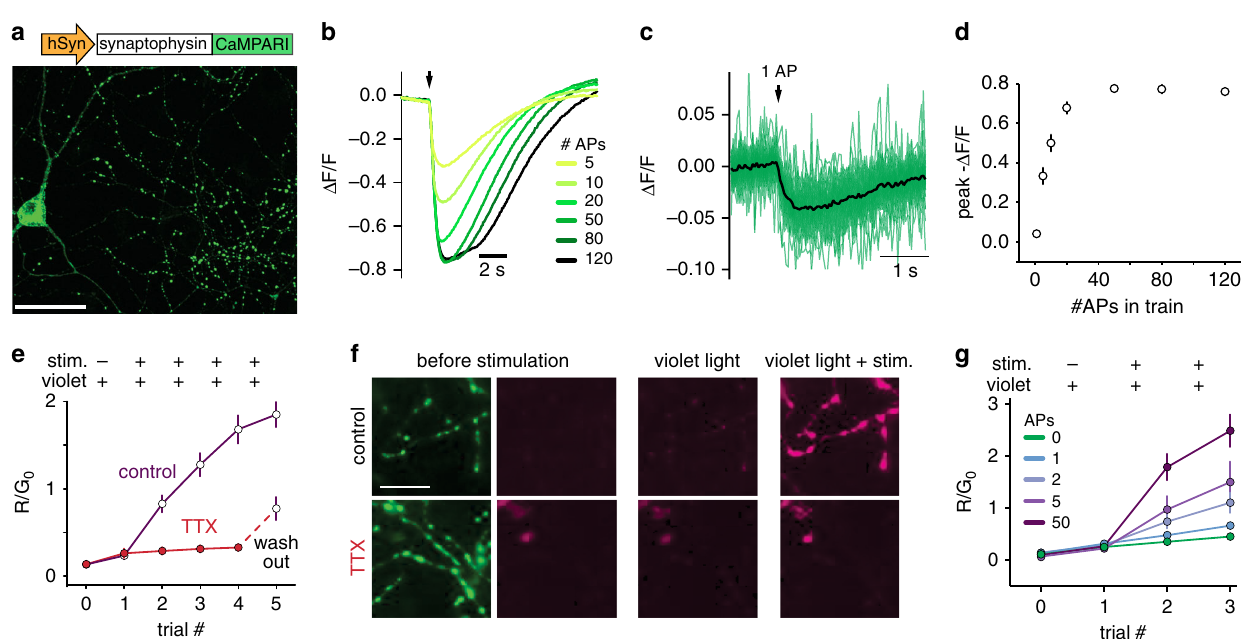
Fig. 1 Synaptophysin-fused CaMPARI marks active presynaptic terminals. a Representative image of cultured rat hippocampal neurons expressing sypCaMPARI. Note the clear punctate labeling of axonal boutons. b Average fl uorescence response of sypCaMPARI boutons (green channel emission) to varying numbers of action potentials (APs) evoked at 50 Hz ( n = 6 neurons, 317 synapses). c Trial-averaged responses to 30 single APs (green, n = 57 synapses). Black line is the average response of n = 3 neurons. d Plot of the maximum Δ F/F versus number of APs from the experiments in b and c . e Plot of initial red to green ratio of boutons expressing sypCaMPARI at baseline, after photoconverting violet light alone (20 light pulses of 1 s duration at 0.1 Hz, 405 nm, 10.8 mW cm − 2 ) and after simultaneous stimulation with trains of 50 APs at 50 Hz (trials 1 – 4). The experiment was performed in the absence or presence of 3 µ M tetrodotoxin to block action potentials (control: n = 8 neurons; TTX: n = 7 neurons). Note that after washing out TTX, the R/G 0 ratio (trial 5) increased to the same amplitude as the fi rst instance in control neurons (trial 2). f Representative red (magenta, trial 0, trial 1, trial 3) and green (green, trial 0) images of boutons from the experiment in e . g The amount of photoconversion (R/G 0 ) in a similar experiment as e but varying the number of APs in a 50 Hz train (20 light pulses of 1 s duration at 0.1 Hz, 405 nm, 54.1 mWcm − 2 ; Stim: 20 bursts at 50 Hz). AP fold increase was statistically different from all other stimulation conditions using a one-way ANOVA with Tukey ’ s post-hoc comparison (* p = 0.032). Neurons per condition: 0 AP ( n = 4), 1 AP ( n = 4), 2 APs ( n = 5), 5 APs ( n = 5), 50 APs ( n = 7). Data are presented as mean ± SEM in d , e , and g . Scale bar: 50 µ